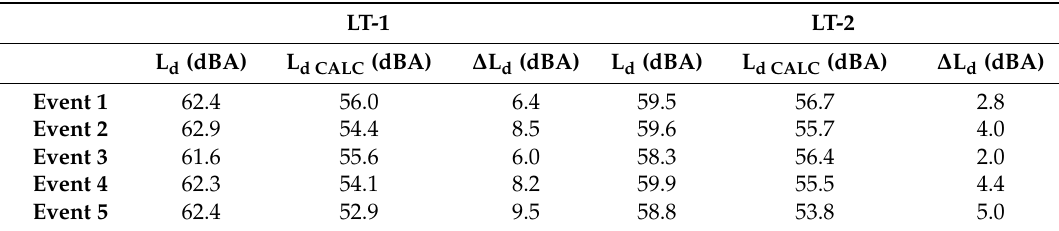
Table 3. Contribution of helicopter emergency operations to the L d indicator at points LT-1 and LT-2.